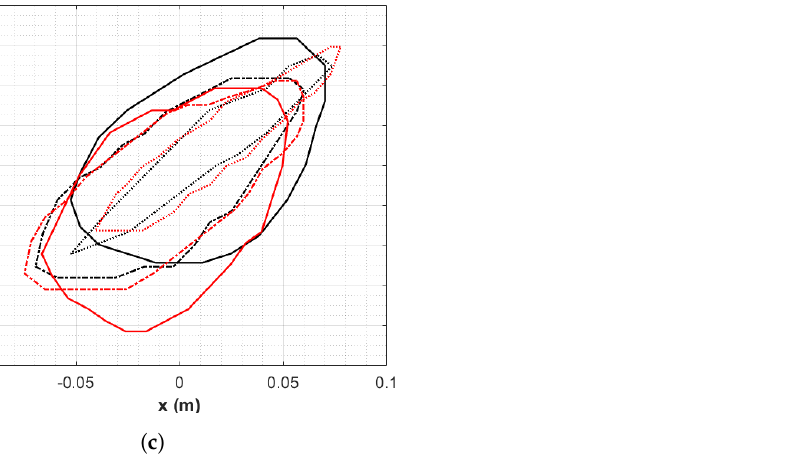
Figure 19. Tracked motions of three points of the mooring line, for a top-end motion of an Amplitude of 0.125 m and periods 2.8,3.5,5.5 s. ( a ) Trajectories of the mooring line lower point of Figure 18 (Marker 9). ( b ) Trajectories of the mooring line middle point of Figure 18 (Marker 5). ( c ) Trajectories of the mooring line upper point of Figure 18 (Marker 2).